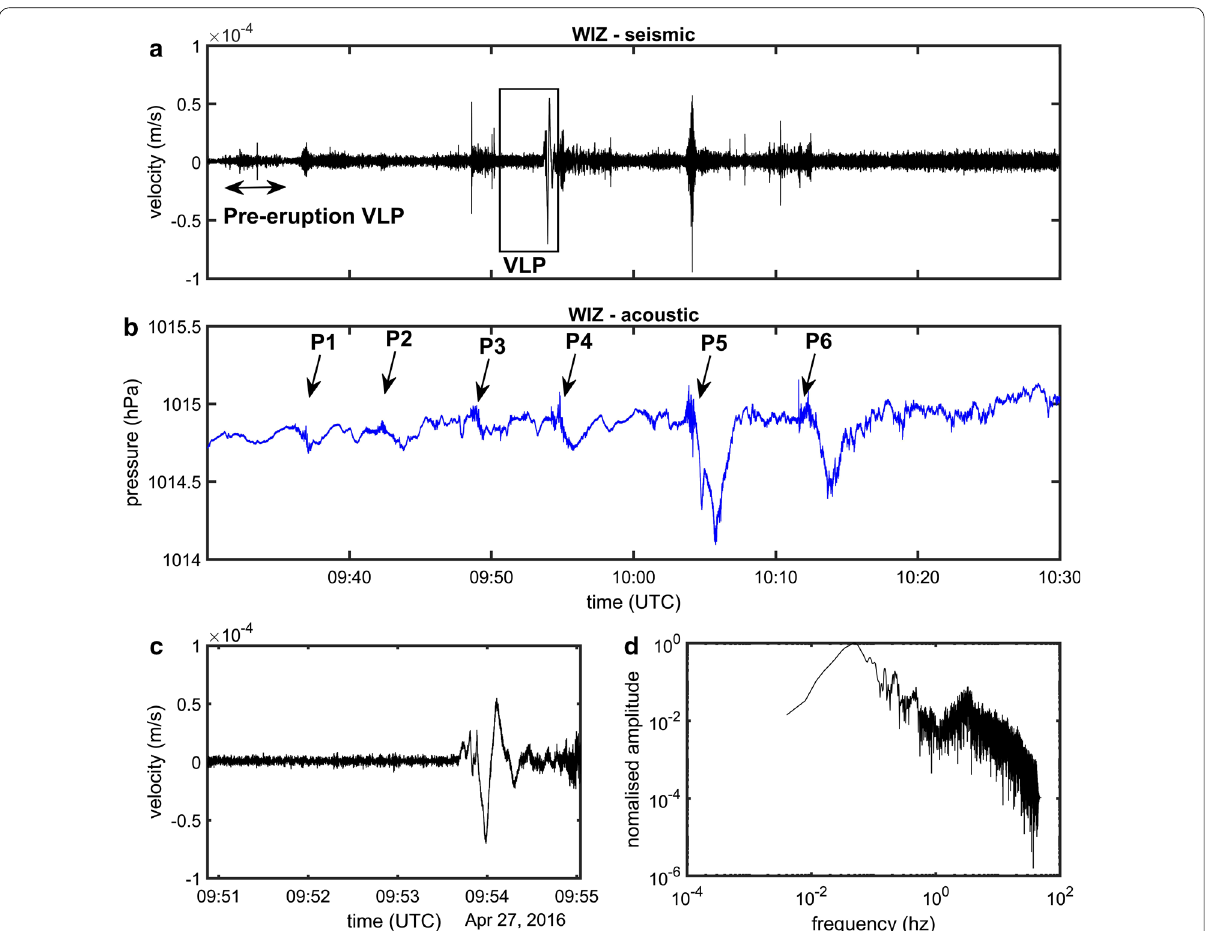
Fig. 2 Time-series of the eruption sequence showing 6 eruption episodes (P1-P6) based on the seismic ( a ) and the time equivalent acoustic ( b ) record. The VLP in inset box ( a ) is shown in detail ( c ) with an associated spectrum shown in ( d